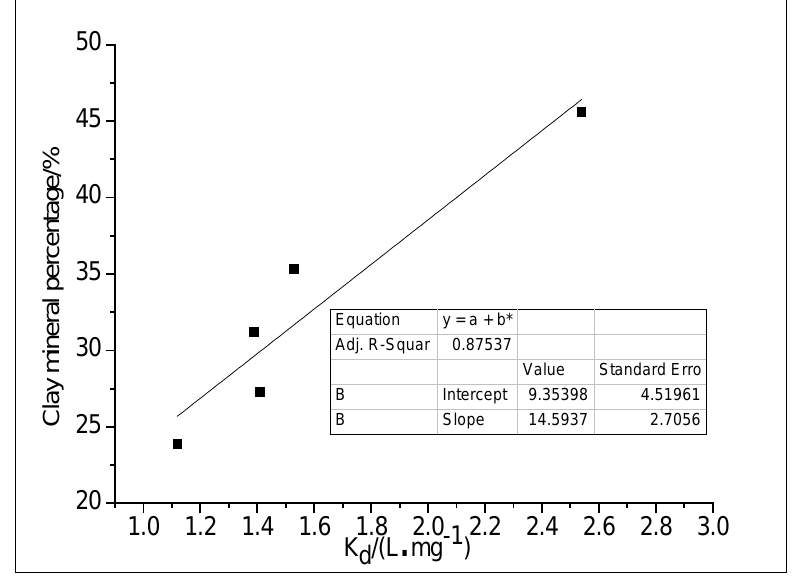
Figure 5. Correlation between the linear distribution coefficient at different depths of clay and the total content of clay minerals.